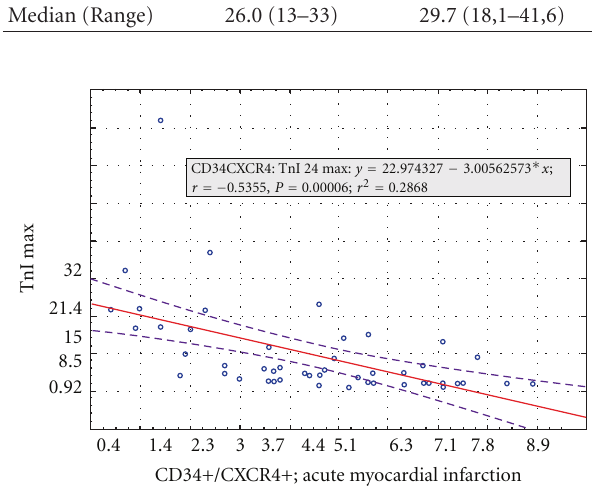
Figure 10: Correlation between CD34+CXCR4+ cells mobilization in the acute phase of MI and maximum levels of troponin I.